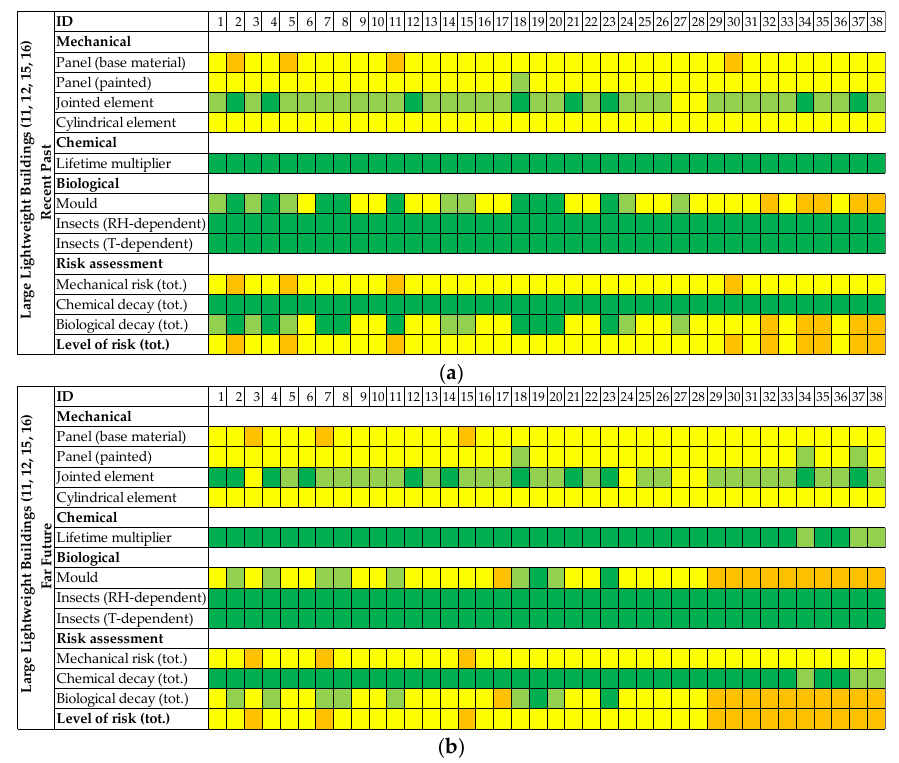
Figure 4. Risk assessment matrix of the deterioration of large lightweight buildings in: ( a ) Recent Past (1961–1990); ( b ) Far Future (2071–2100).